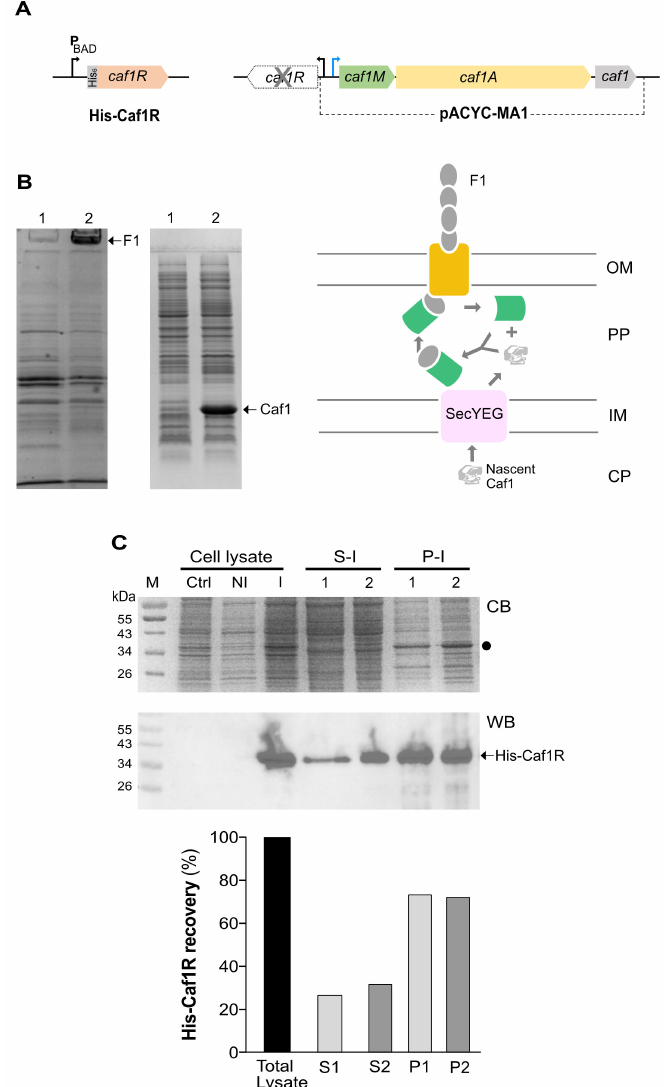
Figure 2. His-Caf1R expression (native caf1R ) from E. coli Top10. ( A ) Schematic of His-Caf1R ex- pressed from pBADhCaf1R and genetic organisation of the caf locus in pACYC-MA1 ( B ) Confirmation of functionality of His-Caf1R. Following 4 h induction with 0.02% L-arabinose, surface Caf1 polymer (F1) was extracted from E. coli Top10 cells transformed with pBAD vector + pACYC-MA1 (lane 1) or with pBADhCaf1R + pACYC-MA1 (lane 2) and processed for SDS-PAGE, as described in methods. Coomassie blue stained SDS-PAG of surface extracted F1 polymer (applied to gel without heating) and the heat-denatured Caf1 subunits are shown. Diagram depicts Chaperone-usher pathway of Caf1 subunit assembly into polymeric fibres of the F1 capsule [4,7,8,51]. Green (Caf1M chaperone) Yellow (OM usher) Grey (Caf1 subunit), OM (outer membrane), IM (inner membrane), PP (periplasm), CP (cytoplasm). ( C ) Solubility analysis of His-Caf1R, CB stained SDS-PAG and WB of respective samples. Cell lysates of indicated samples were prepared by mixing cells from 50 mL culture in 5 mL of lysis buffer (S1/P1 in 20 mM NaPO 4 , 500 mM NaCl, 3 mM DTT, 10% glycerol; pH 7.4 and S2/P2 in 20 mM Tris-HCl, 200 mM KCl; pH 7.4) supplemented with 1 × EDTA-free protease inhibitor followed by sonication. S and P fractions were isolated by ultracentrifugation of sonicated cell lysates. NI (non-induced), I (0.02% L-arabinose induced at 37 ◦ C-4 h). Cell lysates were analysed by mixing into 4 × SDS-PAGE sample buffer. Expected location of His-Caf1R is represented by a dot ( • ). Expression of His-Caf1R was identified with antiHis-HRP monoclonal antibody. M, protein size (kDa)